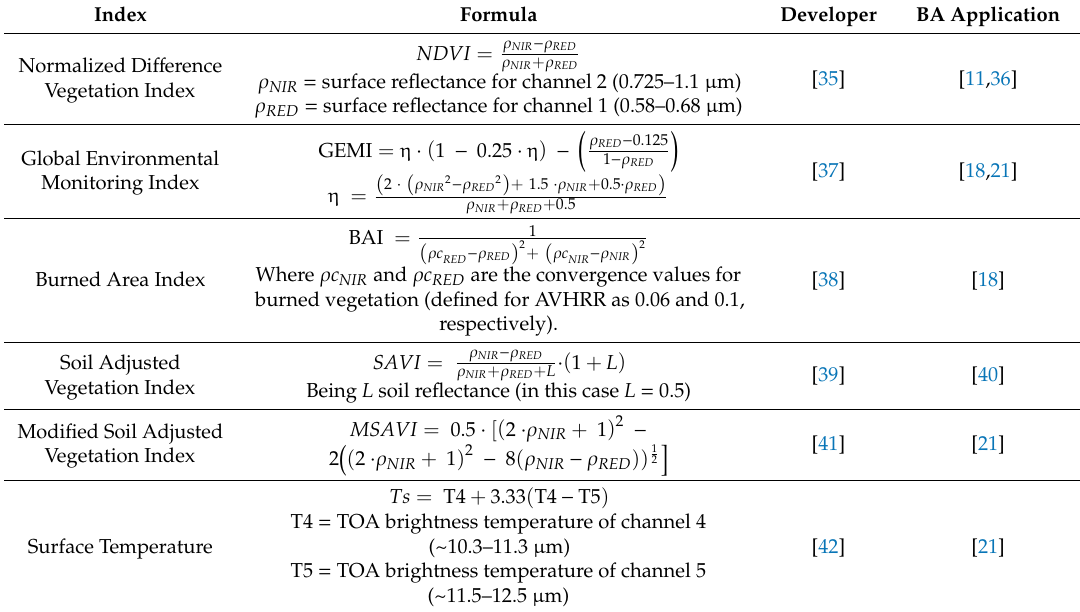
Table 1. Derived bands generated as inputs for the BA algorithm. References for previous studies using each index for BA discrimination are included.